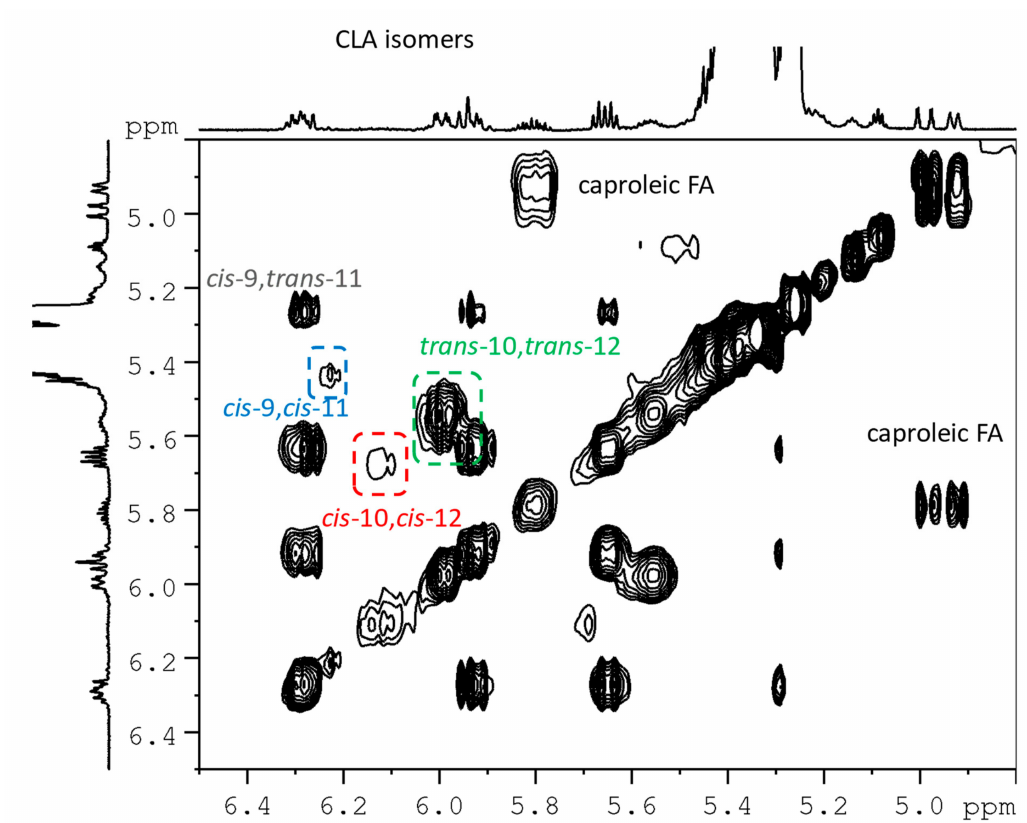
Figure 3. Expanded olefinic region of 1 H- 1 H TOCSY spectrum of goat milk lipid fraction, recorded on a 600 MHz spectrometer, in CDCl 3 at 298 K. Highlighted cross-peaks refer to CLA isomers assigned with this